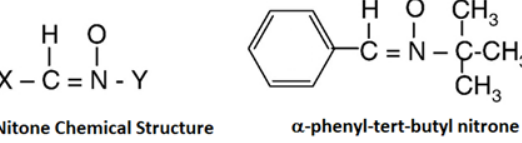
Figure 1. Chemical structures of spin trap: ( a ) nitrone spin trap (representative chemical structure); ( b ) chemical structure of α -phenyl-tert-butyl nitrone.